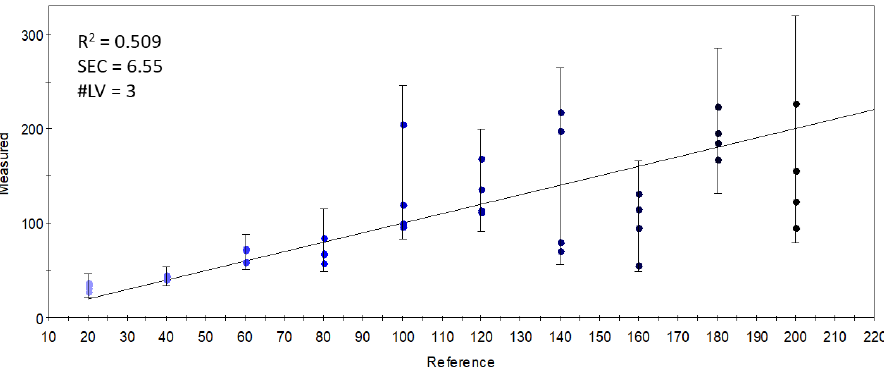
Figure 8. Y-fit of the PLSR calibration on the S17-P100 concentration (mg/10 g product) using data from the selected qualitative sensors (R 2 : determination coefficient; SEC: standard error of calibration; #LV: number of latent variables); the intensity of the colors from light blue to black along the Y-fit line represents the increase in concentration levels of the DHA supplementation.